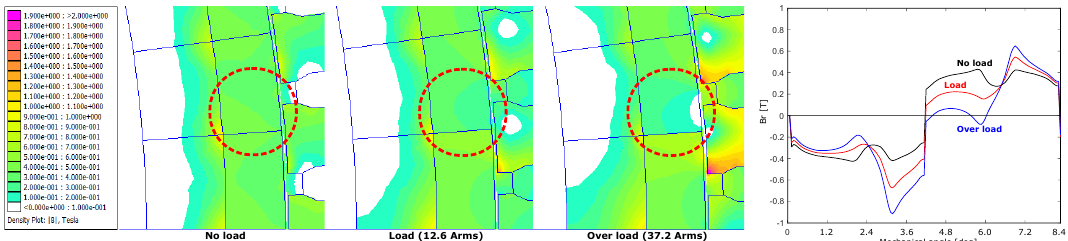
Figure 15. Demagnetization analysis of the Ferrite SPM motor.